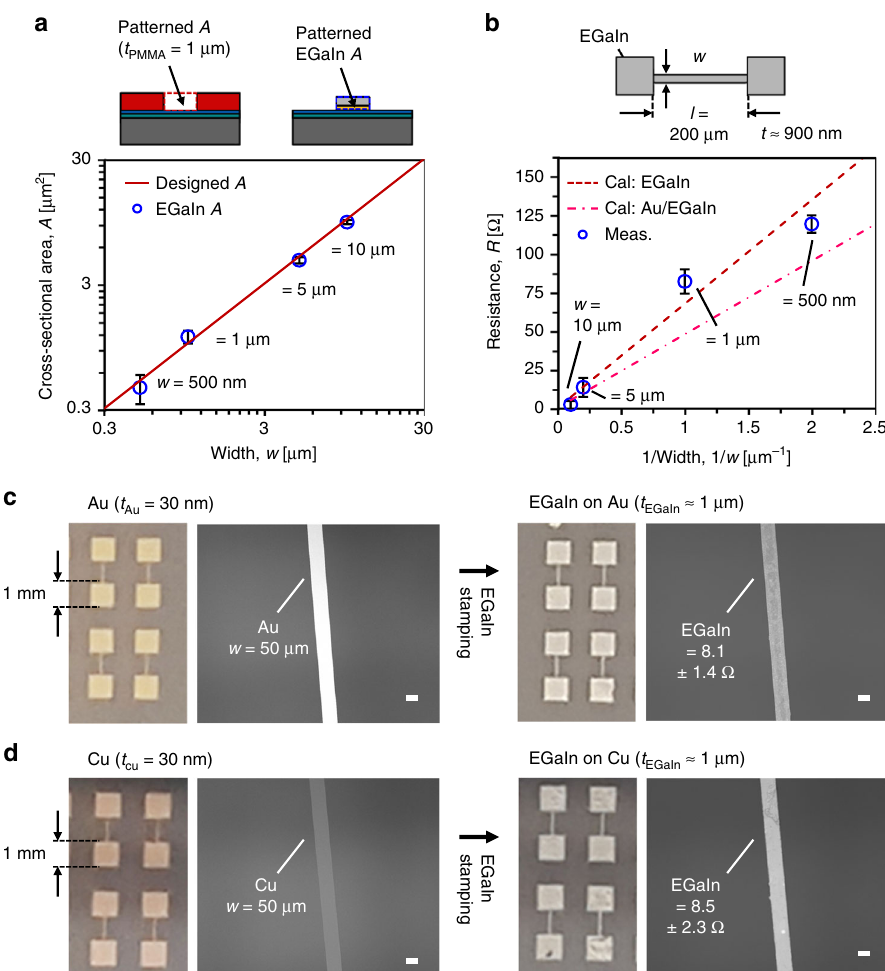
Fig. 3 Characterization of patterned EGaIn nano/microstructures. a Measured cross-sectional area of EGaIn lines (symbols) with widths from 10 µ m to 500 nm, compared to the designed cross-sectional area (solid line), as a function of the line width. The y-error bars represent the standard deviation. b Calculated (symbols) and measured resistance of 200- µ m-long EGaIn lines as a function of line width. The y-error bars represent the standard deviation. The dashed line accounts for the resistance of the EGaIn fi lm only while the dot-dashed line assumes a theoretical parallel circuit of the EGaIn fi lm and the underlying Au adhesion layer. c , d EGaIn patterning characterization using different metallic adhesion layers, namely Au and Cu. c Patterned Au structures after lift-off process without EGaIn stamping and stamped and patterned EGaIn structures on Au. d Patterned Cu structures after lift-off process without EGaIn stamping and stamped and patterned EGaIn structures on Cu. Scale bars in c and d indicate 40 μ